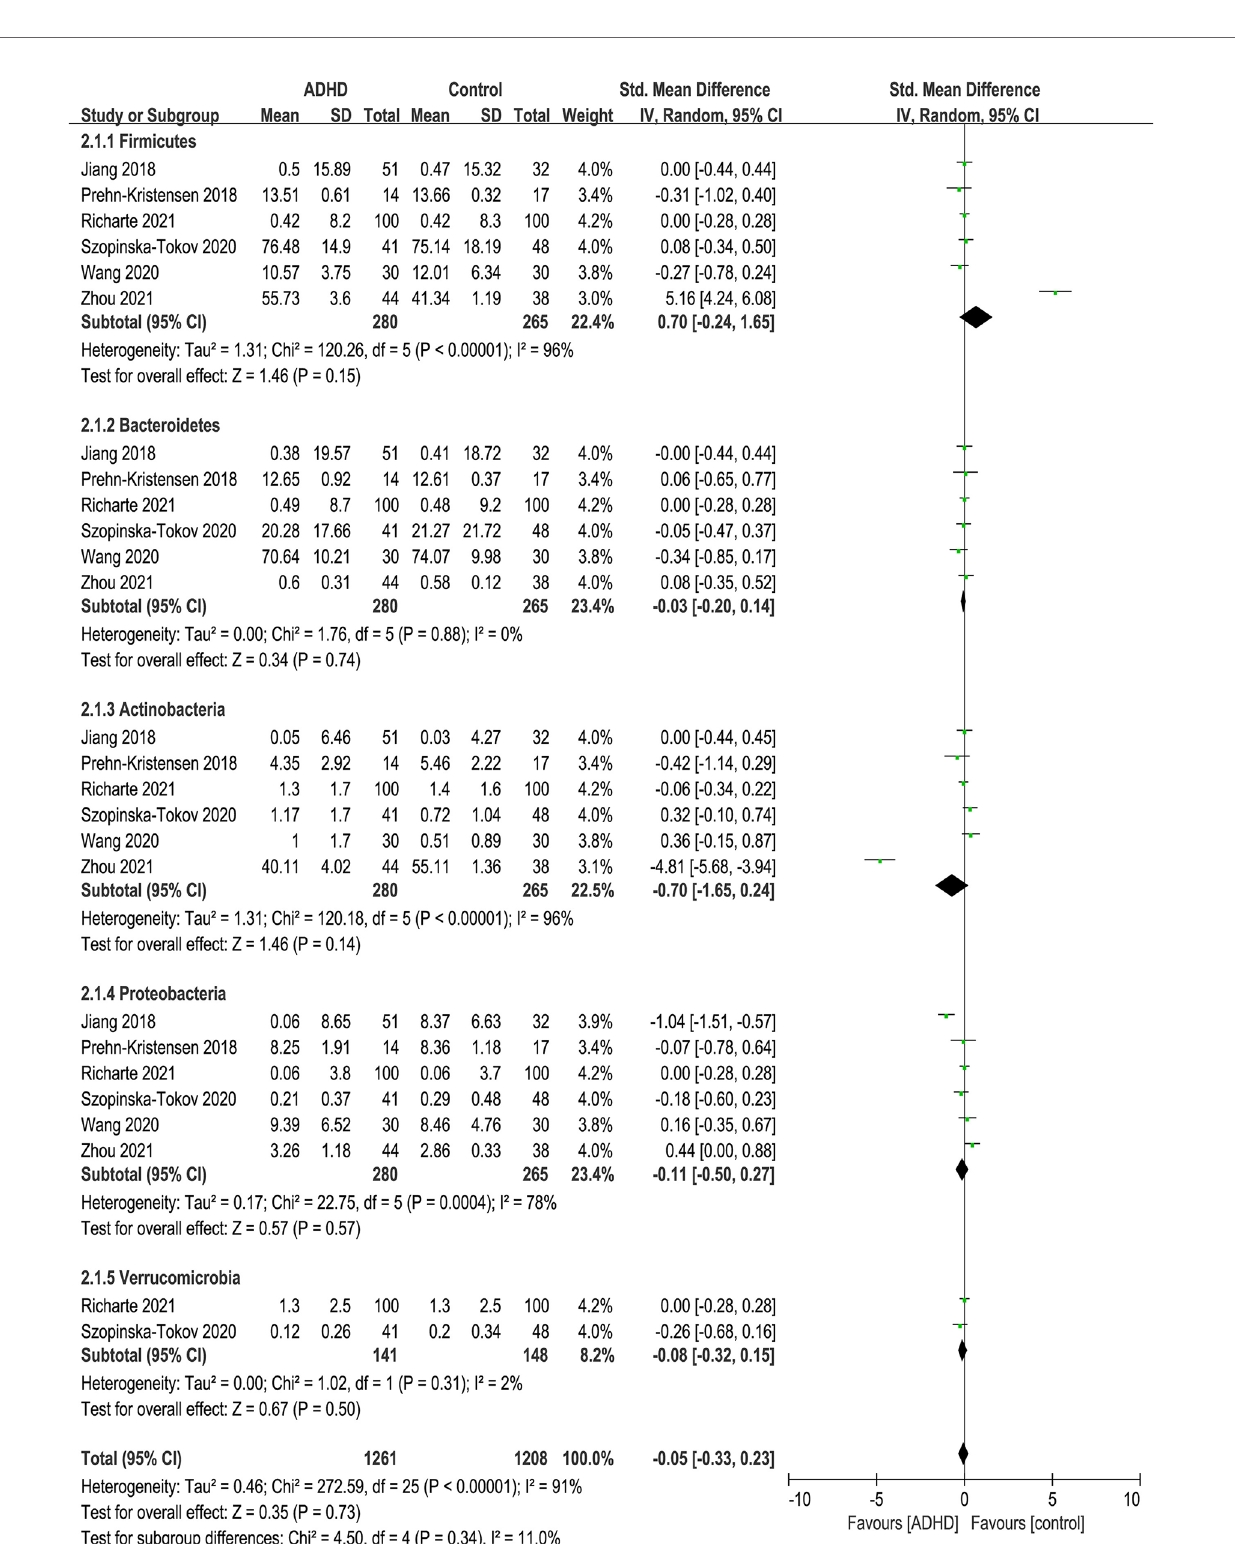
FIGURE 5 | Forest plot of relative abundance of Phylum in the Gut Microbiota of ADHD Compared with HCs. CI, con fi dence interval; SMD, standardized mean difference.